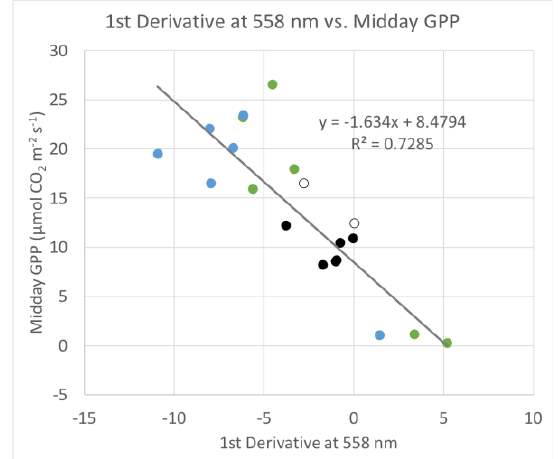
Figure 8 . First derivative at 558 nm from DESIS compared with midday GPP from flux towers. Point colors are described in Fig. 3 caption.